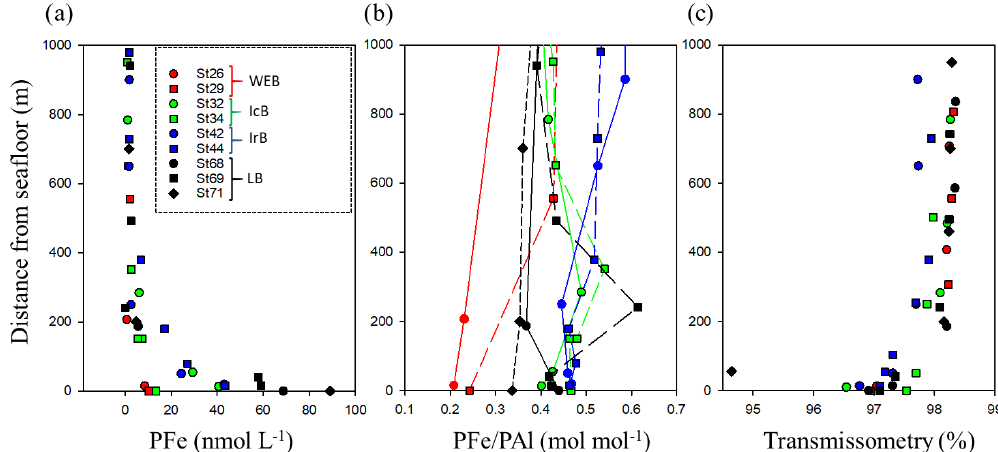
Figure 10. Benthic nepheloid layers (BNLs) encountered along the GA01 section and observed through (a) PFe total, (b) PFe / PAl ratio, and (c) beam transmissometry (%) as a function of depth above the seafloor (m) at selected stations where a decrease in transmissometry was recorded in the West European (red dots), Iceland (green dots), Irminger (blue dots), and Labrador basins. Noted that the UCC PFe / PAl ratio reported from Taylor and McLennan (1995) is 0.21molmol − 1